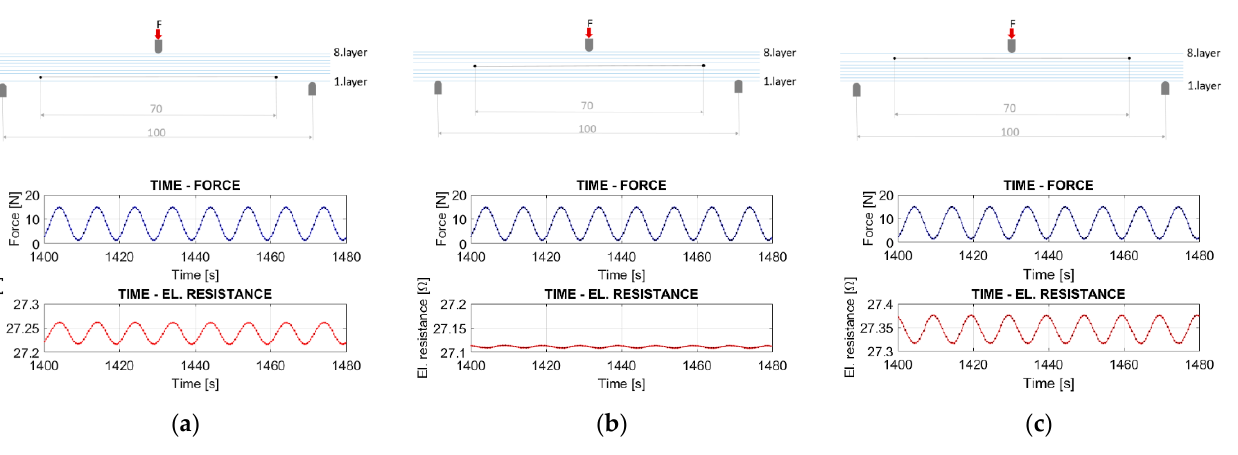
Figure 7. Peak-to-peak relative values of the measured signal from CFSs integrated into the specimens before and after impact loading: ( a ) results for specimens T300; ( b ) results for specimens T300–detail; ( c ) results for specimens 95 A; ( d ) results for specimens 70 A.